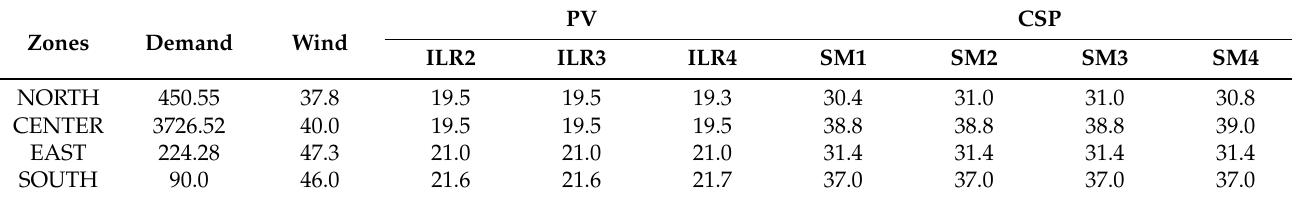
Table 2. Regional predicted yearly demand (MWh/yr) and bias-corrected solar and wind CFs (%) averaged over the year 2018 per zone and technology. SM1: CSP without storage; ILR > 1 or SM > 1: with increasing levels of storage.